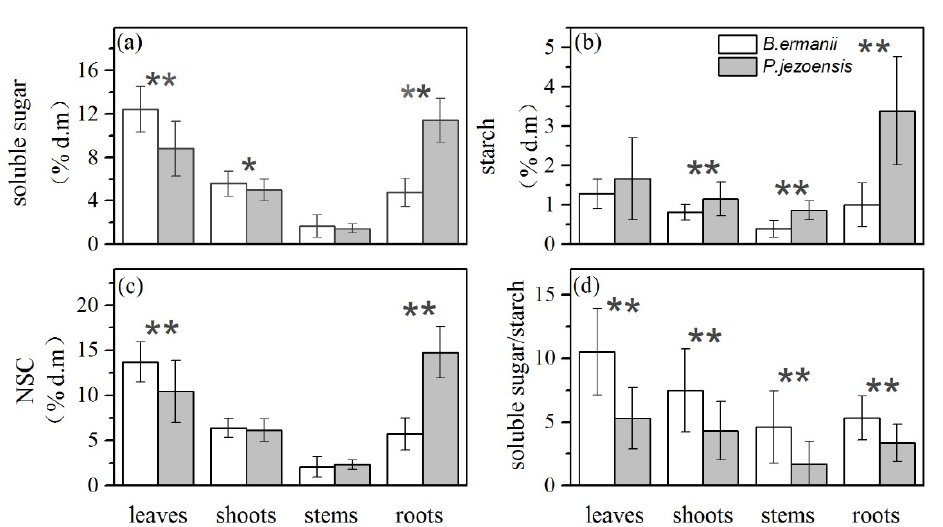
Table 1. Effects of tissue and species on the concentrations of non-structural carbohydrates (NSC), soluble sugar, starch and soluble sugars/starch, tested using a mixed effects model. The treeline was used as a random variable to account for between-treeline variance. The significant levels of p < 0.05 are shown in bold.